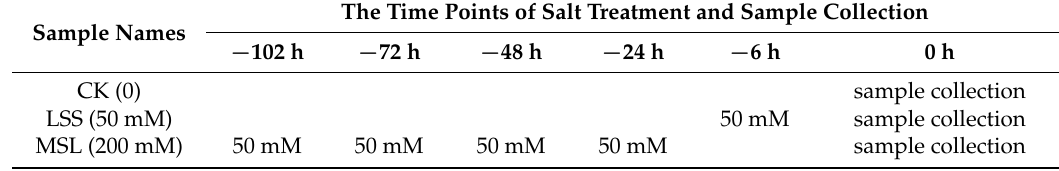
Table 1. Experimental design and sample collection of salt-treated 30-day-old